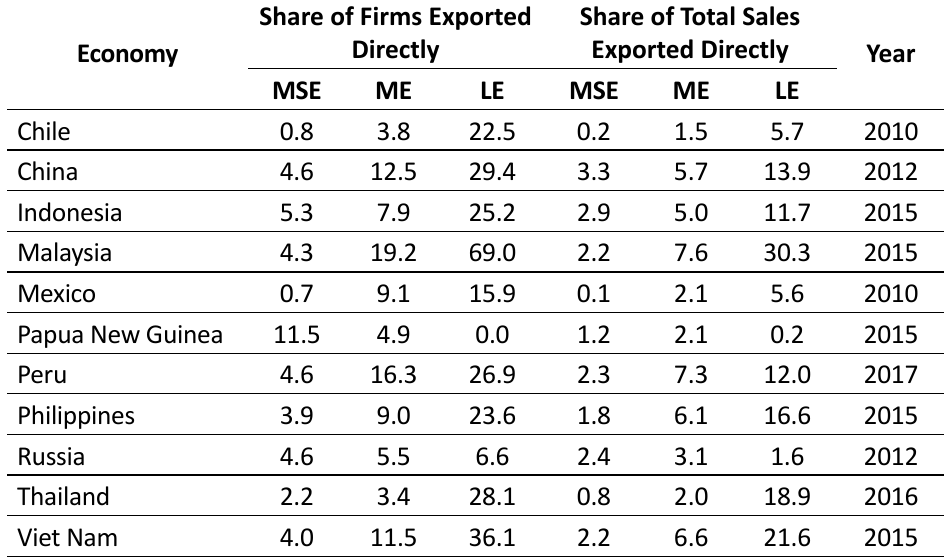
Table 1: Exporters as a Share of Firms and Exports as a Share of Total Sales by Size in Sever- al Economies in the AP Region (%) Share of Firms Exported Economy